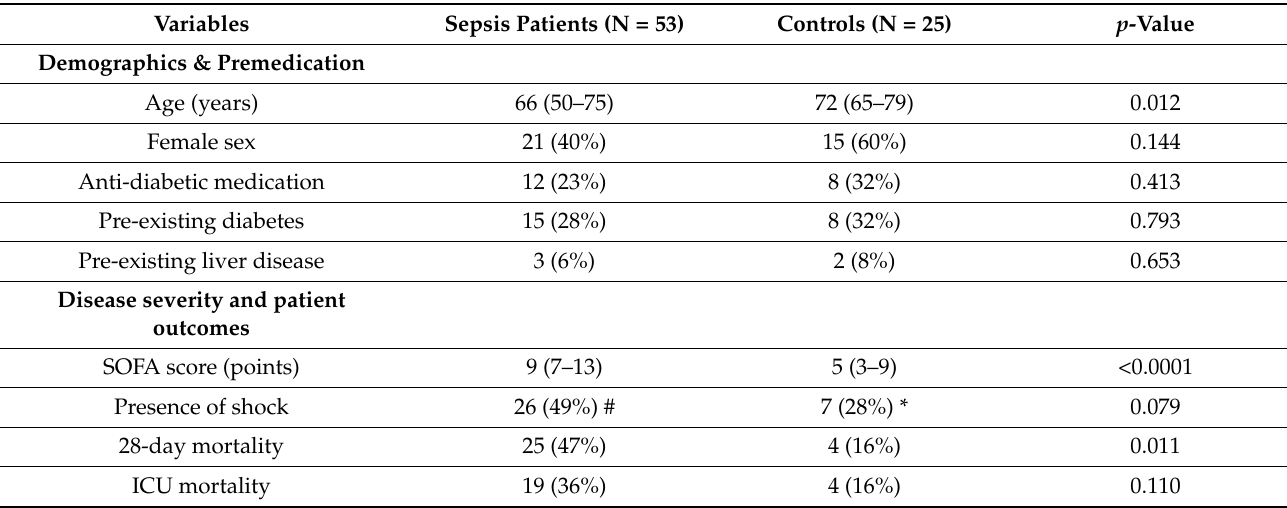
Table 1. Demographics, disease severity, and patient outcomes in the sepsis and control cohort. Variables Sepsis Patients (N =